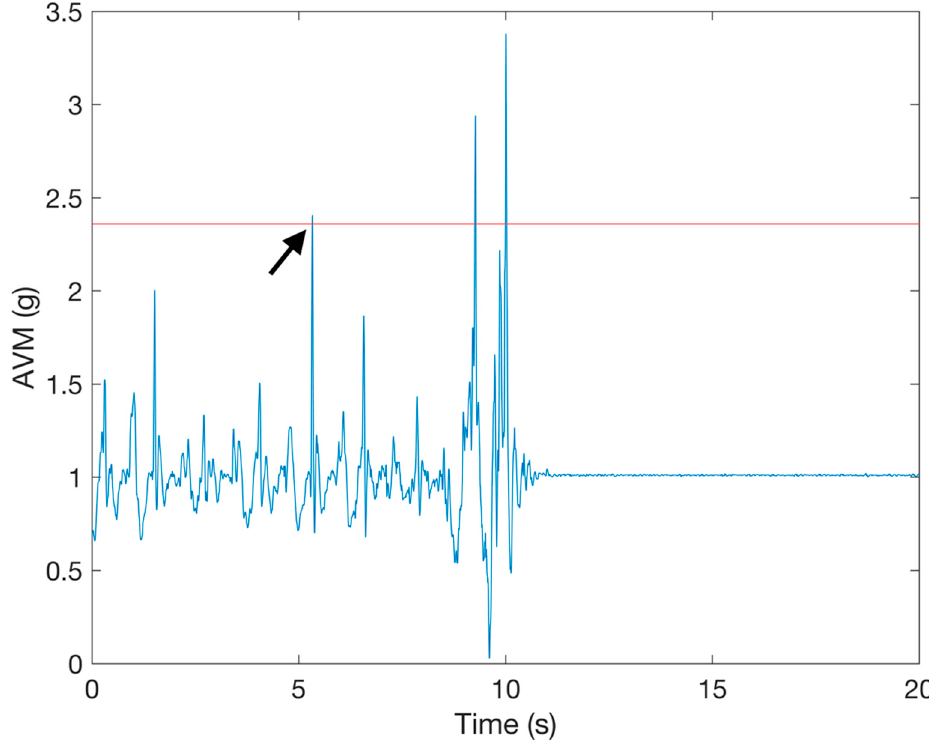
Figure 5. An example of a fall record from the FallAllD dataset that contains an ADL before the fall. The arrow indicates the point in the signal where the ADL causes detection of a false potential fall event.